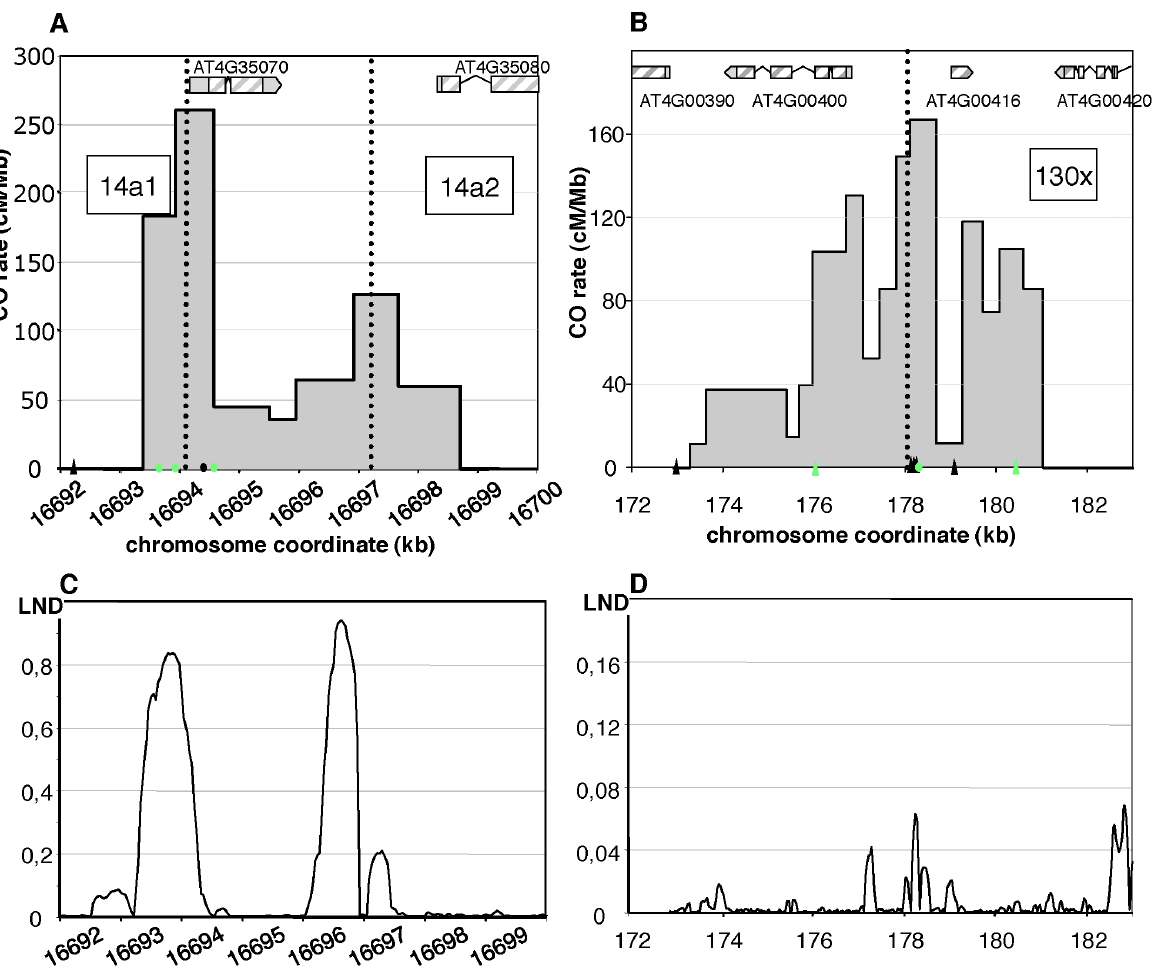
Figure 3. Distribution of CO rates across the 14a (A) and 130 6 (B) hotspots. One hundred and four COs were analyzed at 14a (62 at 14a1 and 42 at 14a2) and 167 at 130 6 . Grey dotted vertical lines: median positions of the hotspots. On the x axis: triangles are positions of insertions- deletions larger than 7 bp (from the left to the right of 130 6 : 20, 13, 12, 70, 10, 7 and, 11 bp); green triangles are positions of indels used to detect NCOs; green dots are SNPs used to detect NCOs; the black dot on the x axis in (A) is the position of the microsatellite. Gene structures along the hotspot regions are displayed on top of graphical areas (light hashed grey: exons, dark grey: UTR, broken lines: introns). (C)(D) Low nucleosome density (LND) at 14a and 130 6 . LND is from published nucleosomal DNA microarray hybridization experiments, where a high signal represents an absence of nucleosomal DNA [28].